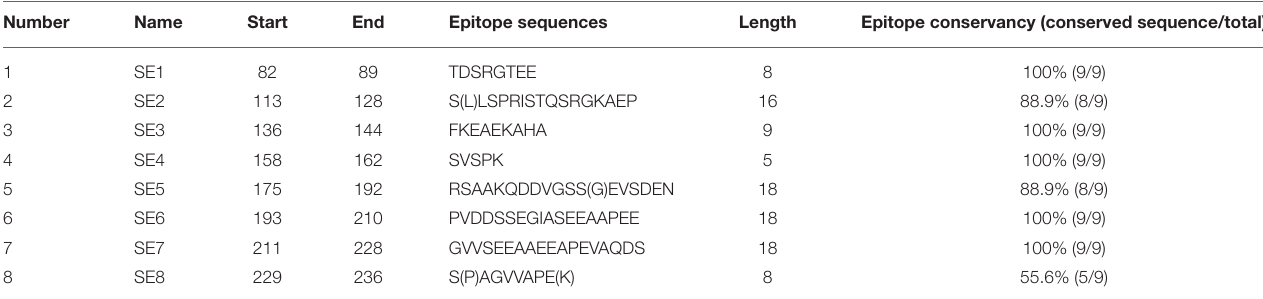
TABLE 3 | Linear epitopes of the OmpA protein of Anaplasma marginale predicted using BepiPred and ABCpred and epitope conservancy result.